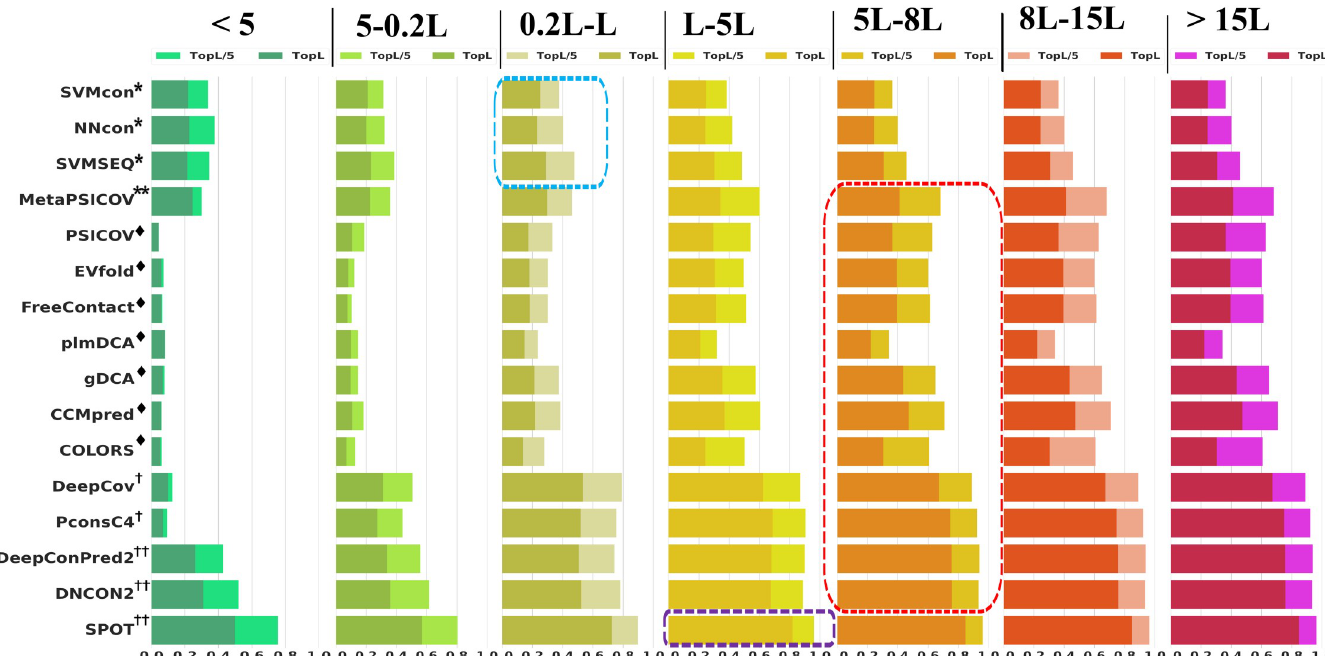
Fig 4. Prediction precisions of top L and L/5 contacts with the variation of N eff on TestSet1. From left to right the bar plots illustrate the prediction precisions of top L < 5/ 5–0.2L/ 0.2-L/ L-5L/ 5L-8L/ 8L-15L/ > 15L. Methods in the blue/red/purple squares show the best performance with minimum N contacts for proteins with N eff of 0.2L-L/L-5L/5L-8L. The MSA with N eff > 5L-8L permits “the best for all” and enables “simplicity over